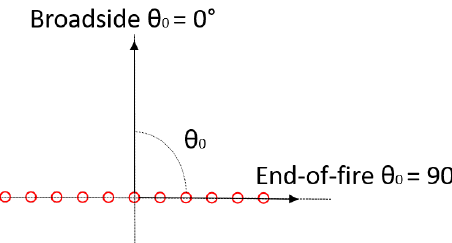
Figure 2. Broadside end end-of-fire steering directions (broadside orthogonal to the linear array, end-of-fire parallel to the direction of the